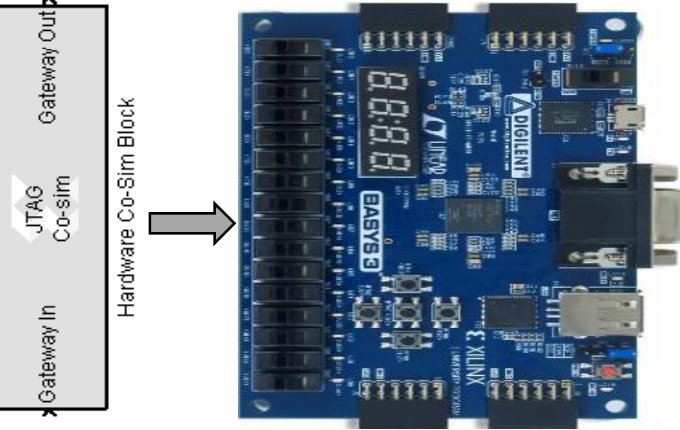
Figure 11. Closed loop representing hardware / software co-simulation.